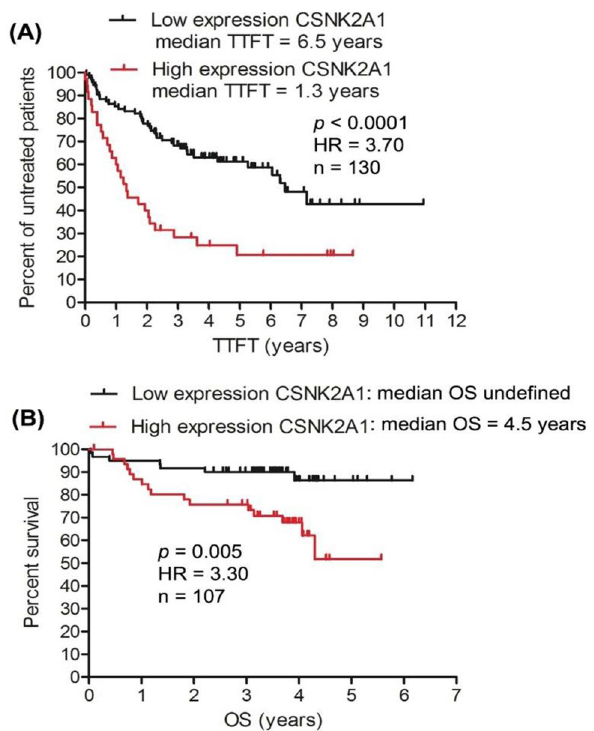
Figure 1. High expression of CSNK2A1 gene is associated with short TTFT and short OS in CLL patients. Two CLL transcriptomics data sets from GEO were used for the analysis; TTFT analysis was done on the data set GSE39671 ( A ) and the OS analysis was performed on the data set GSE22762 ( B ). GEO: gene expressing omnibus; HR: hazard ration of high-expression versus